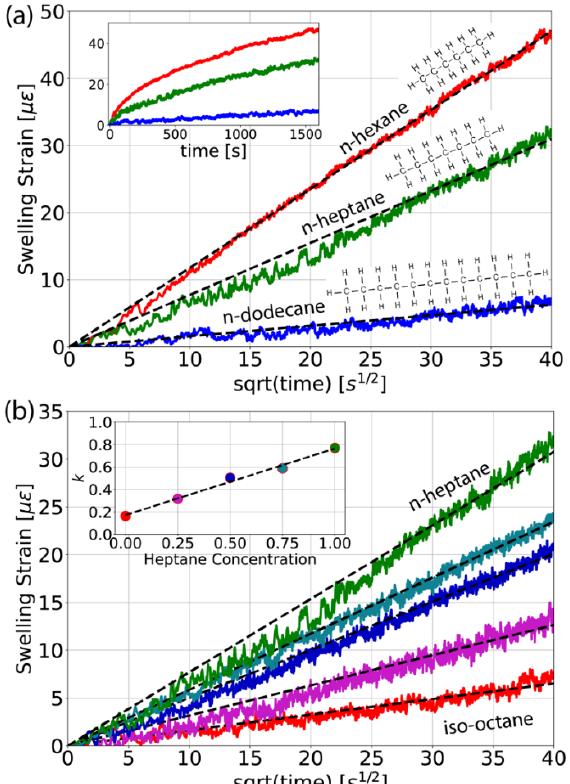
Figure 6. Swelling strain for alkanes plotted against the square root of time. ( a ) Different chain length; the inset shows the same data plotted against time. ( b ) Different concentrations of n-heptane in iso-octane from 0% to 100% heptane concentration with steps of 25%. The inset shows that the diffusion constants increase linearly with the concentration of n-heptane in iso-octane.